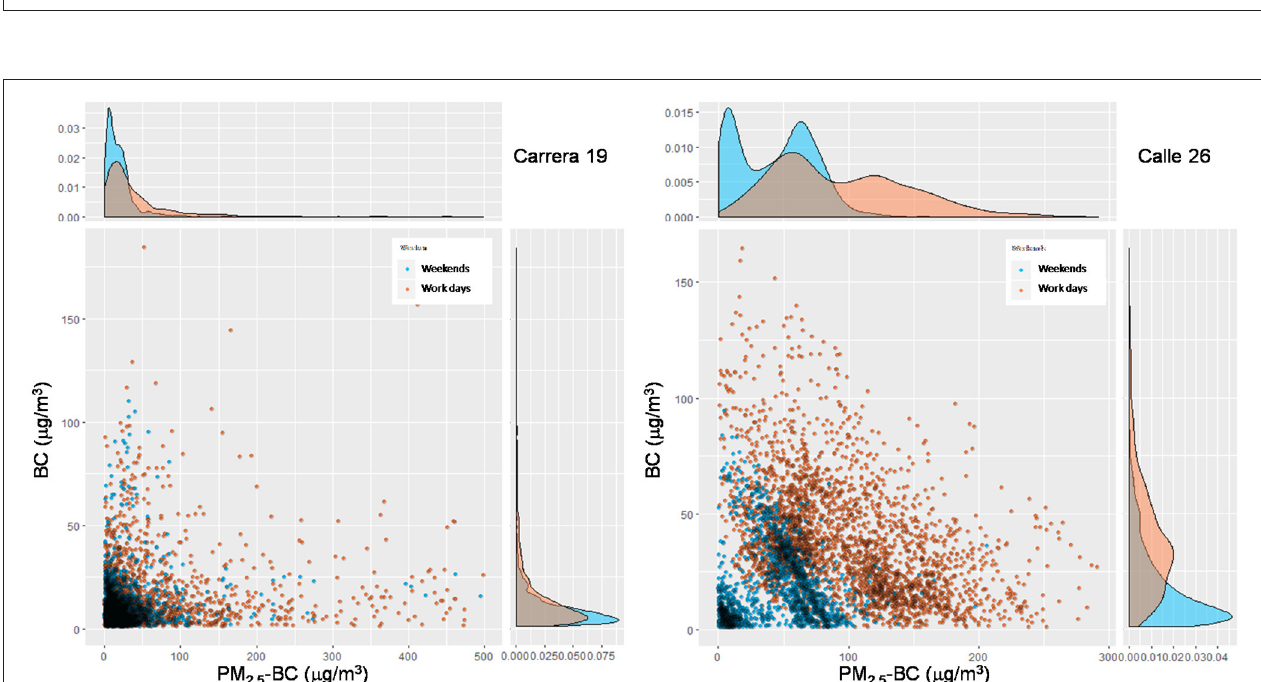
FIGURE 6 | Scatter plots and distributions of PM 2.5 and BC concentrations measured along two bike-paths, during work days and weekend.